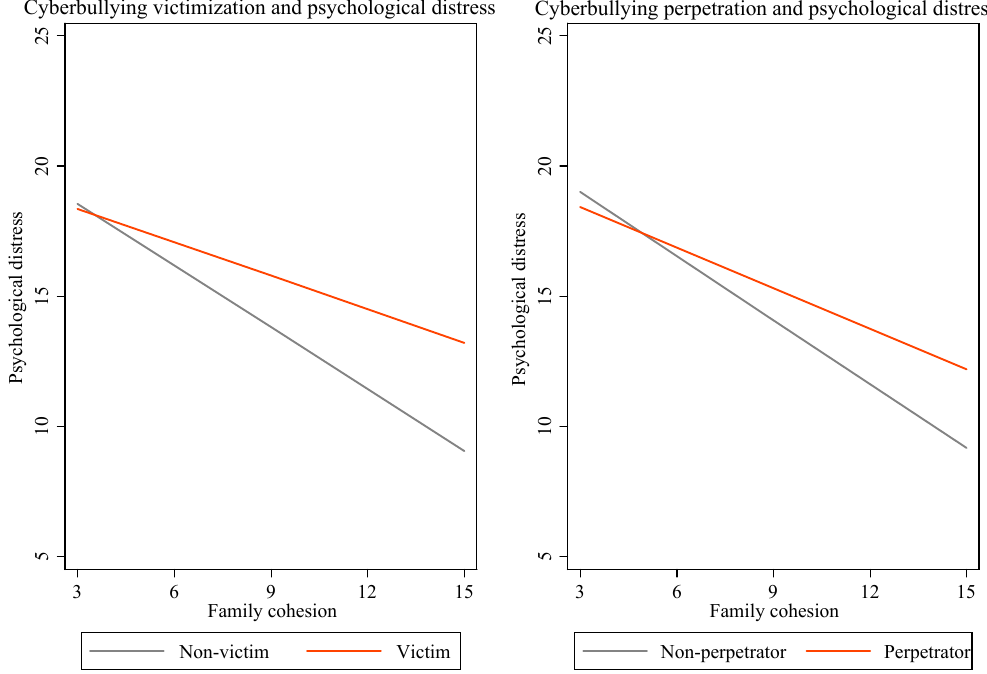
Figure 1. The moderating effects of family cohesion.